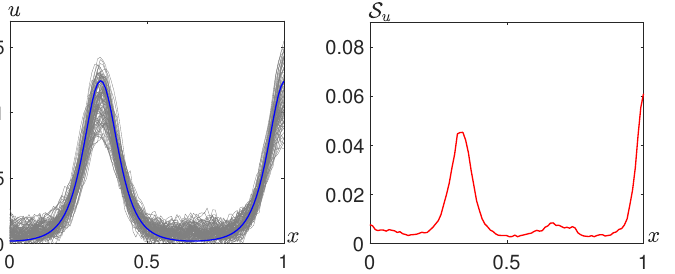
Figure 7. Probabilistic distribution ( left ) and mean-square deviation ( right ) of random states around the stable 1.5 ↑ pattern in Systems (1), (2) with a = d = e = 0.5, b = c = 1, D u = 5 × 10 − 4 , D v = 0.02, ε = 0.1.